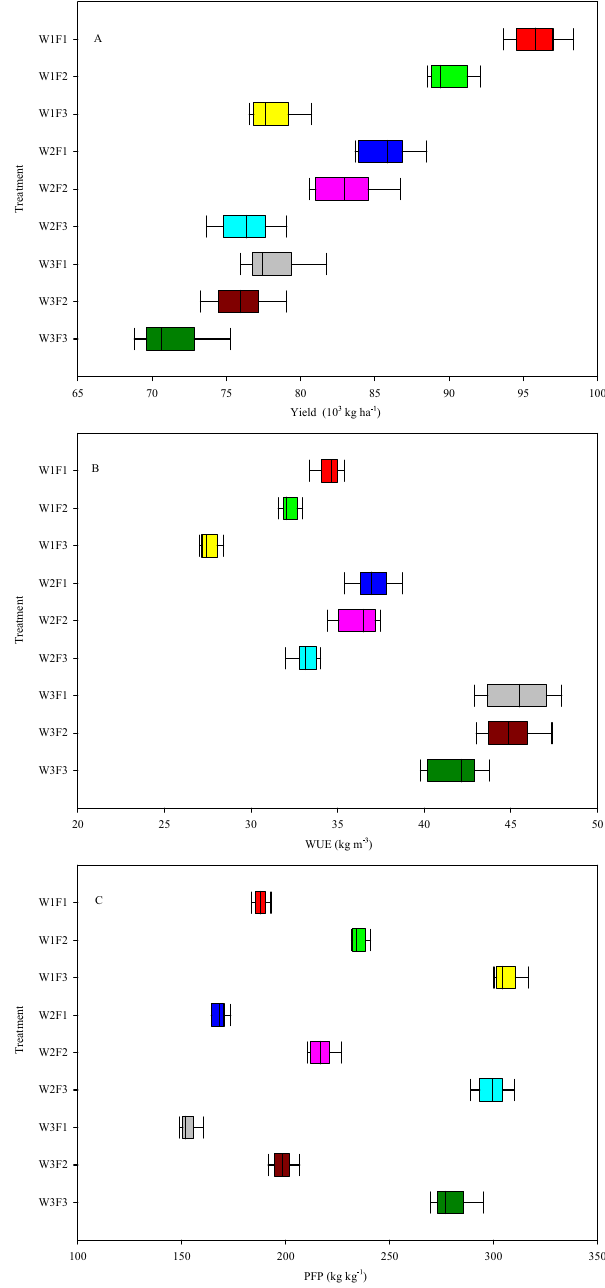
Figure 1. Effects of irrigation and fertilization treatments on fruit yield ( A ), water use efficiency (WUE) ( B ) and partial factor productivity (PFP) ( C ) in three consecutive growing seasons in 2012 − 2013. The treatments are noted as W1, 100% ET 0 ; W2, 75% ET 0 ; W3, 50% ET 0 ; F1, N240 − P 2 O 5 120 − K 2 O150 kg ha − 1 ; F2, N180 − P Lines in the boxes show the median values. Data are the means of nine replicates: three growing seasons and three replications per